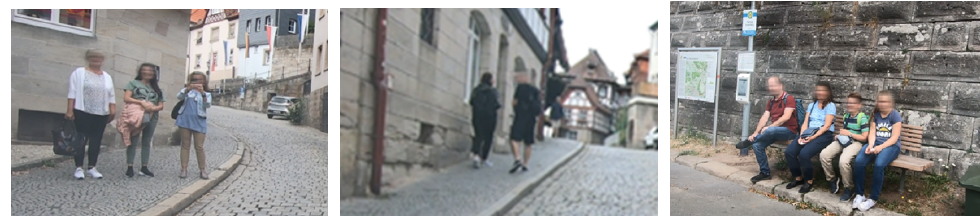
Figure 3. Reaction of pedestrians to automated bus.